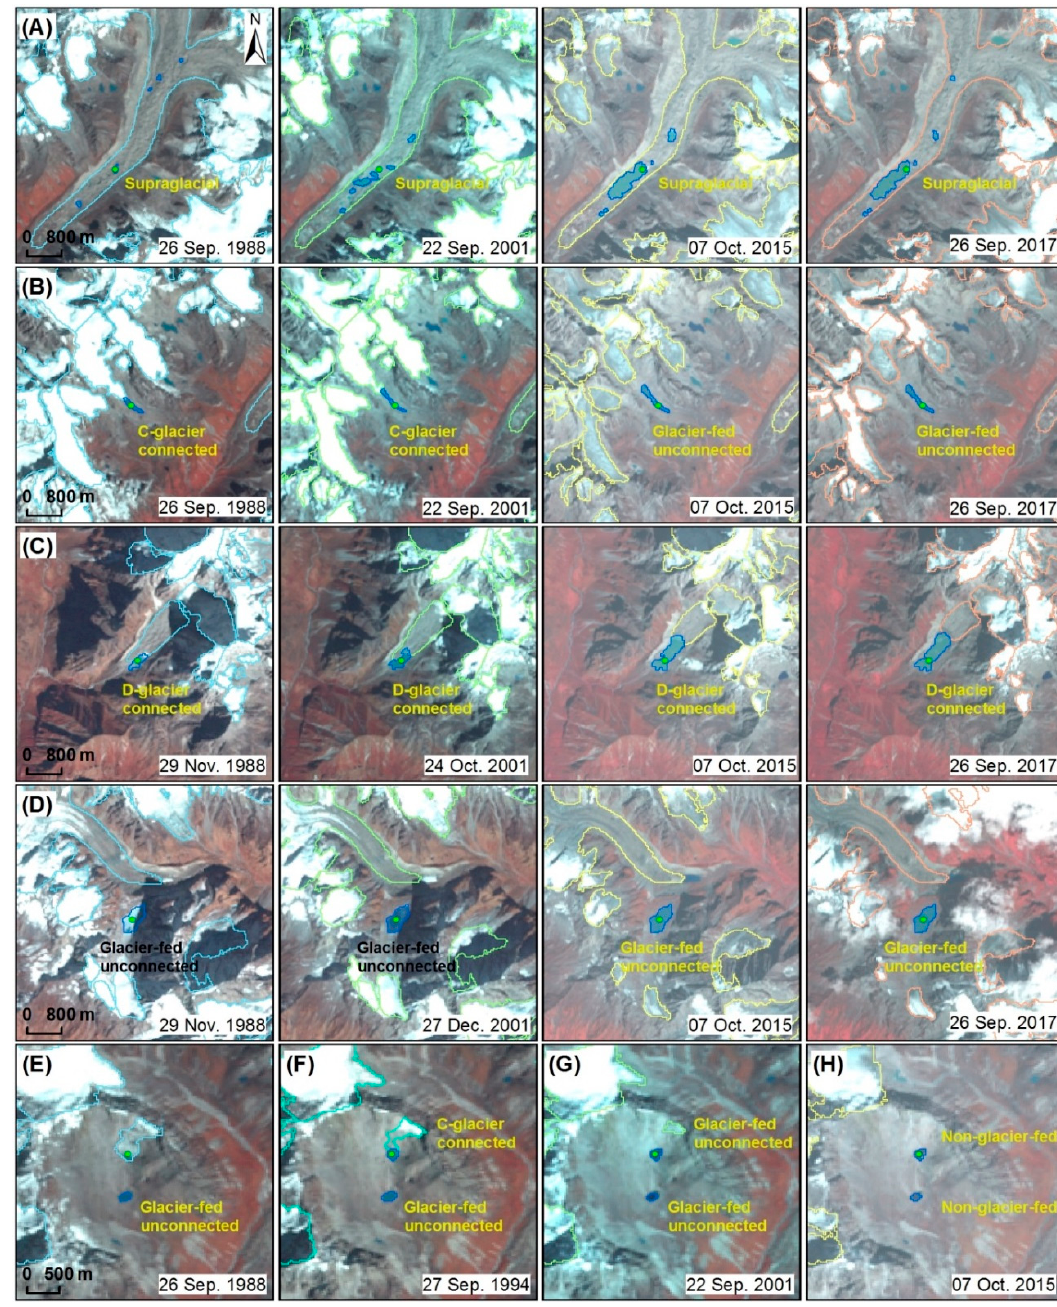
Figure 9. Evolution and changing status of typical glacial lakes (labeled by green dots) superimposed on background Landsat images: ( A ) supraglacial lake on Lalaga Glacier (85.563661°E, 28.426213°N); ( B ) lake connected with C-glacier (85.522556°E, 28.415646°N); ( C ) lake connected with D-glacier (85.494453°E, 28.508467°N); ( D ) unconnected glacier-fed lake (85.170447°E, 28.292374°N); ( E ) no lake at the glacier terminus (85.593496°E, 28.378879°N); ( F ) newly-formed lake connected with C-glacier; ( G ) lake unconnected with C-glacier; ( H ) lake becoming non-glacier-fed after the disappearance of the upstream glacier.